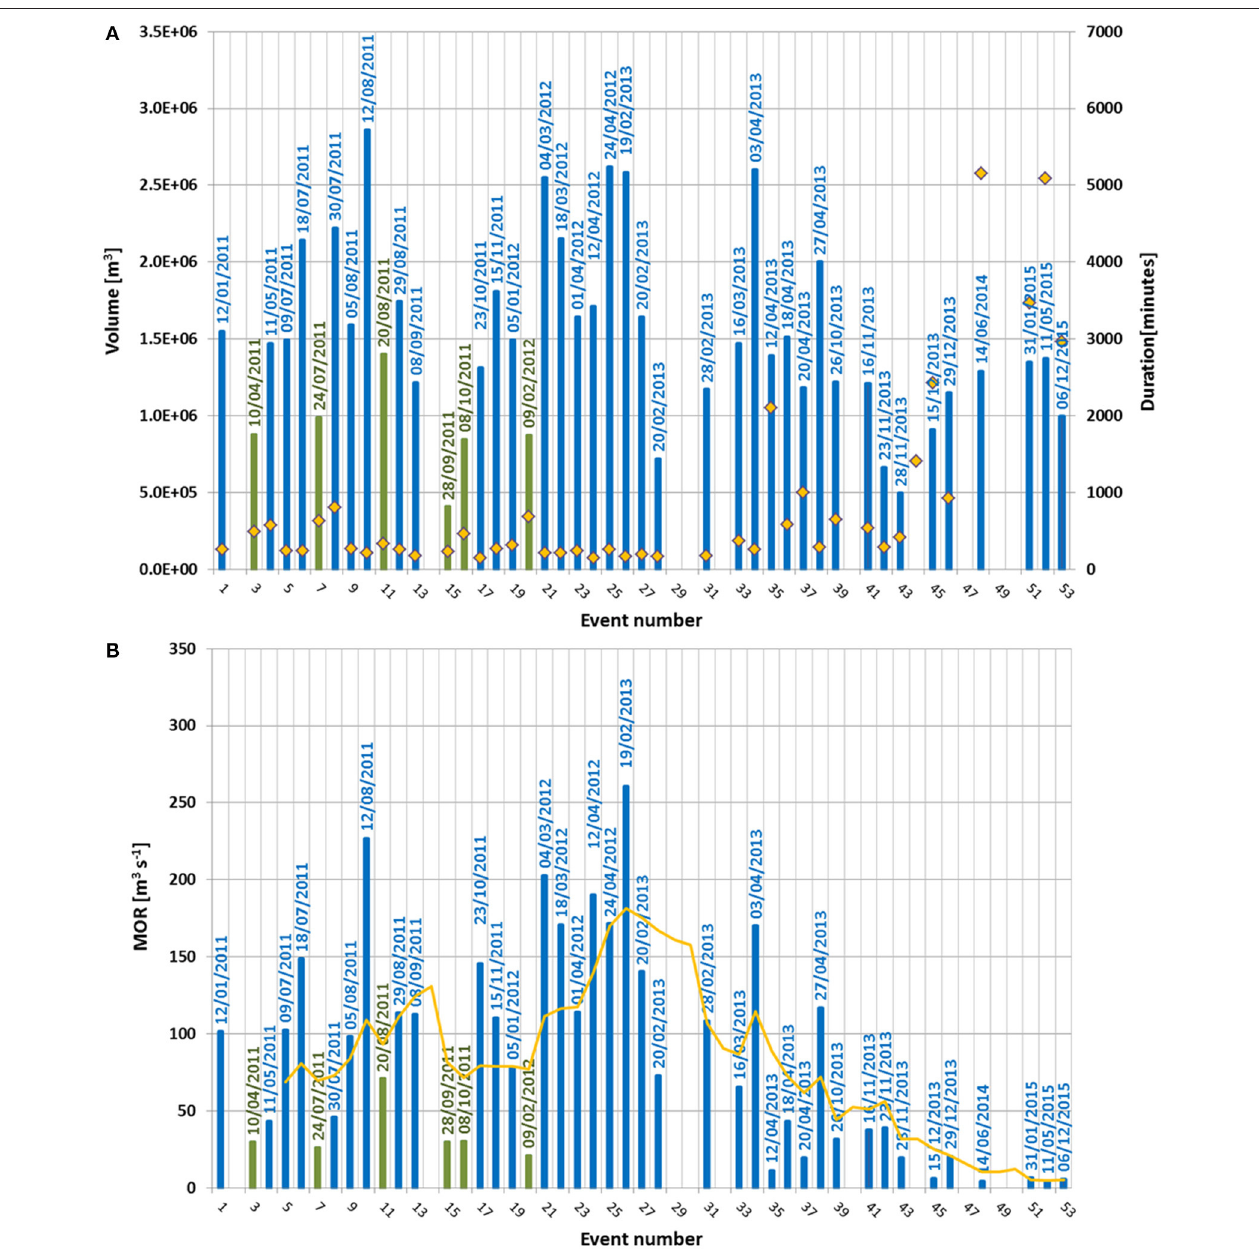
FIGURE 5 | Volumes (blue bars for cloud-free events, green bars for cloud-contaminated events) and durations (orange diamonds) of the events occurred between 2011 and 2015, excluding the two long-lasting effusive periods of 2014 (A) . The MOR (blue bars for cloud-free events, green bars for cloud-contaminated events) and 5-period moving average of the MOR time series (orange line) show the temporal non-stationarity of eruption intensity, mainly decreasing from February 2013, and reaching the minimum values since 2014 (B)